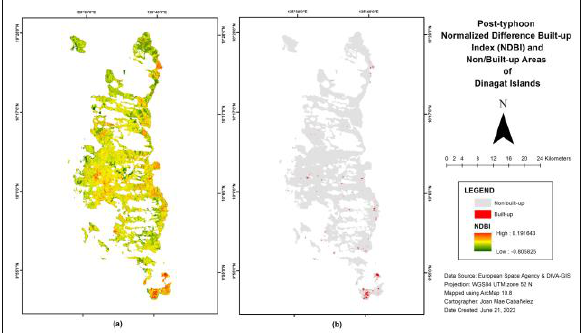
Figure 10 . NDBI and built-up layers of Dinagat Islands during post-typhoon condition.